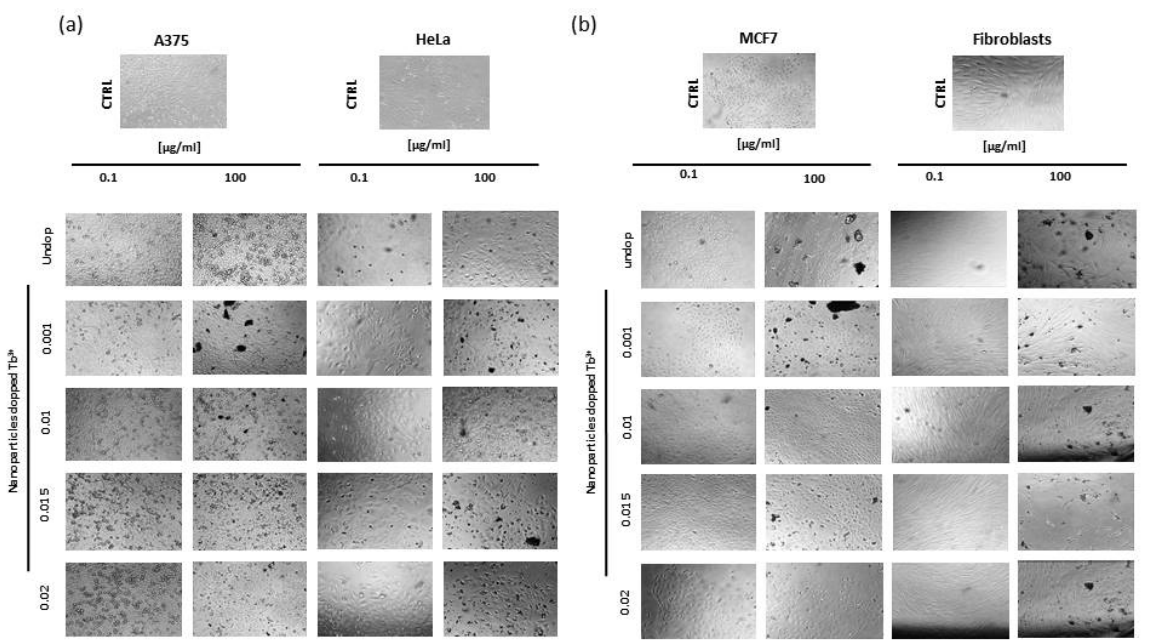
Figure 9. Representative microscopy images of control cells against treated cells with particles pre- pared with x = 0, 0.001, 0.01, 0.015 and 0.02 M Tb 3+ in ( a ) A375 and HeLa, and ( b ) MCF7 and Fibro- blasts cell lines. All images are at 10× magnification.